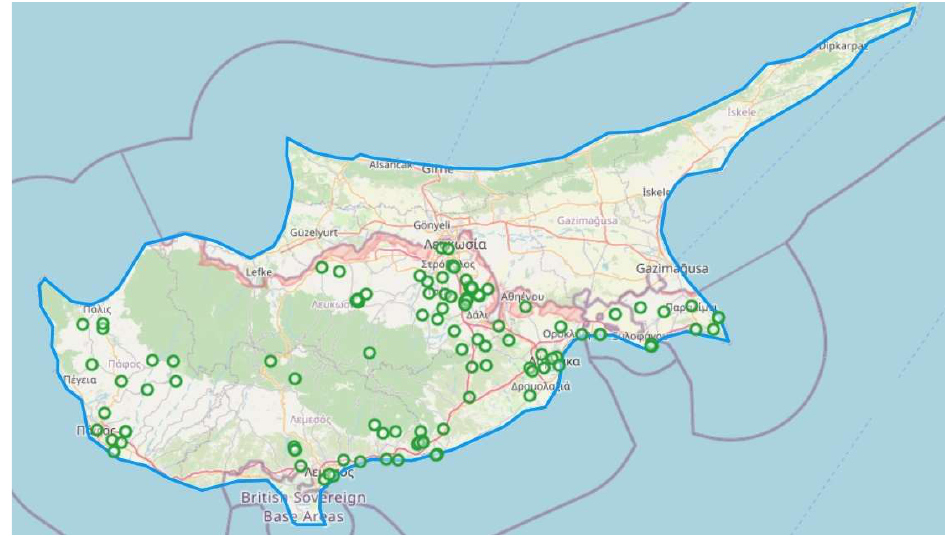
Figure 1. Mapping of the SWAN industrial ecosystem in Cyprus.